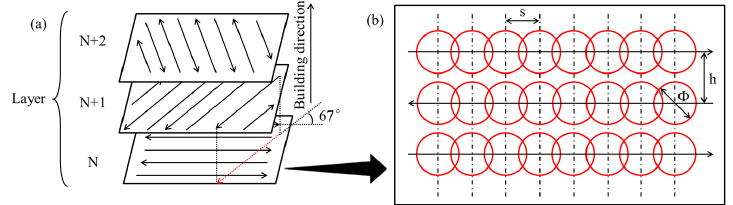
Figure 2. ( a ) Scanning strategy; ( b ) spot-to-spot fabrication process, where “s” is point distance, “h” is hatch space, and “ Φ ” is laser beam spot size.